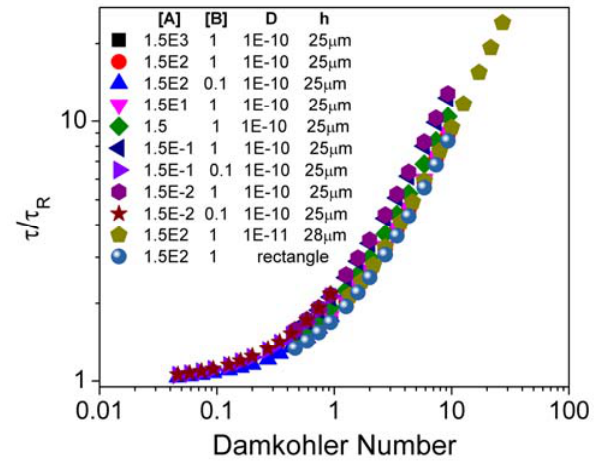
Figure 5. Binding time τ , normalized with respect to the reaction-time scale τ function of the Damköhler number Da. By analog with the definition of τ Equation (16), we define τ as the time taken to reach 1 − e − 1 ≈ 63% of the equilibrium concentration. Results from a representative subset of the studies performed are presented, where the channel height H = 50 μ m. As expected, the ratio τ /τ to zero, and is approximately equal to Da in the opposite limit. A rectangular suspended sensor was also modeled to demonstrate that these results are independent of the precise sensor